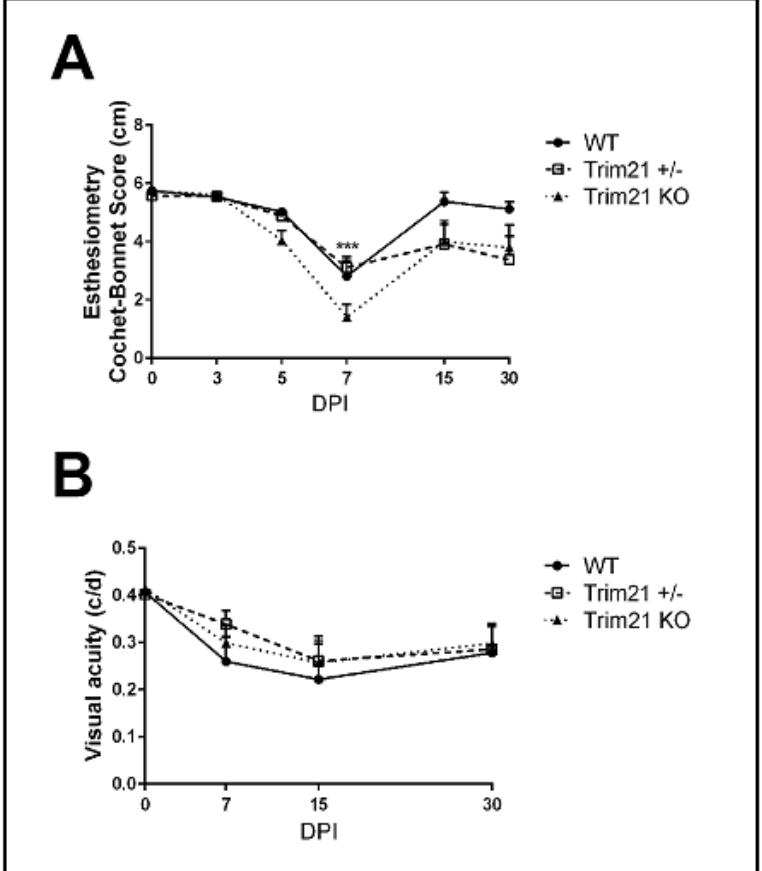
Figure 6. Performance of the visual axis drops in WT, TRIM21+/ − , and TRIM21 KO mice following HSV-1 infection. Male and female C57BL/6 (WT), TRIM21+/ − and TRIM21 KO mice (n = 5–15/group/time point) were infected with HSV-1 (10 3 PFU/cornea). At the indicated time point, before (0) or after infection, the mice were evaluated for ( A ) mechanosensory function using a Cochet–Bonnet esthesiometer, to measure the blink reflex, or ( B ) assessed for visual acuity by optomotor kinetic tracking. All mice lost corneal sensation, with a maximum effect at 7 days post infection (DPI) and partial to complete recovery (in the case of WT mice) by 30 DPI ( A ). A 40% reduction in visual acuity was observed in all mouse groups, with a maximum effect at 15 DPI and partial recover by 30 DPI ( B ). Each point graphed represents the mean ± SEM. *** p < 0.001 comparing the 7 DPI to uninfected (0) time point, as determined by ANOVA and Tukey’s multiple comparison test.